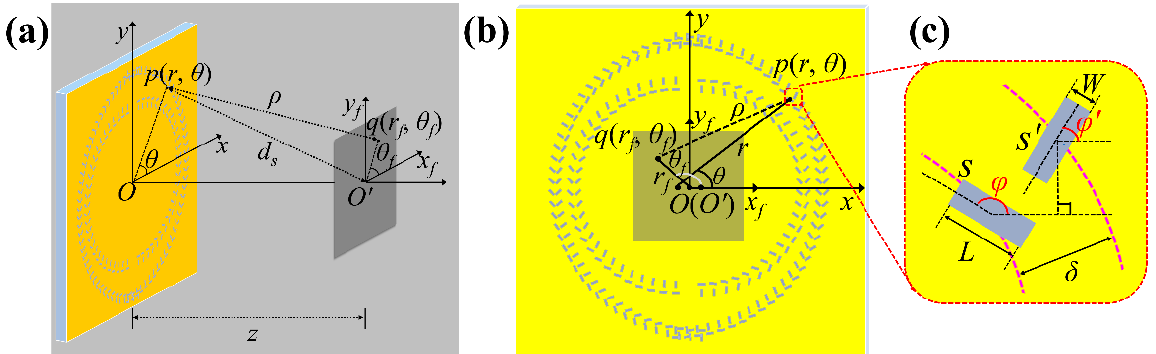
Figure 1. ( a ) Geometry of the optical system for generating dual VBs with metasurface sample of CSRs, z = 10 µ m. ( b ) Overlapped view of the sample plane Oxy and the observation plane O’x f y f for geometrical analysis. ( c ) Enlarged view of a unit of slit pair. The length ( L ) and width ( W ) of a single slit element are L = 300 nm and W = 100 nm, respectively; optical path difference δ between from the slits s and s’ to O ’ is λ / 2.